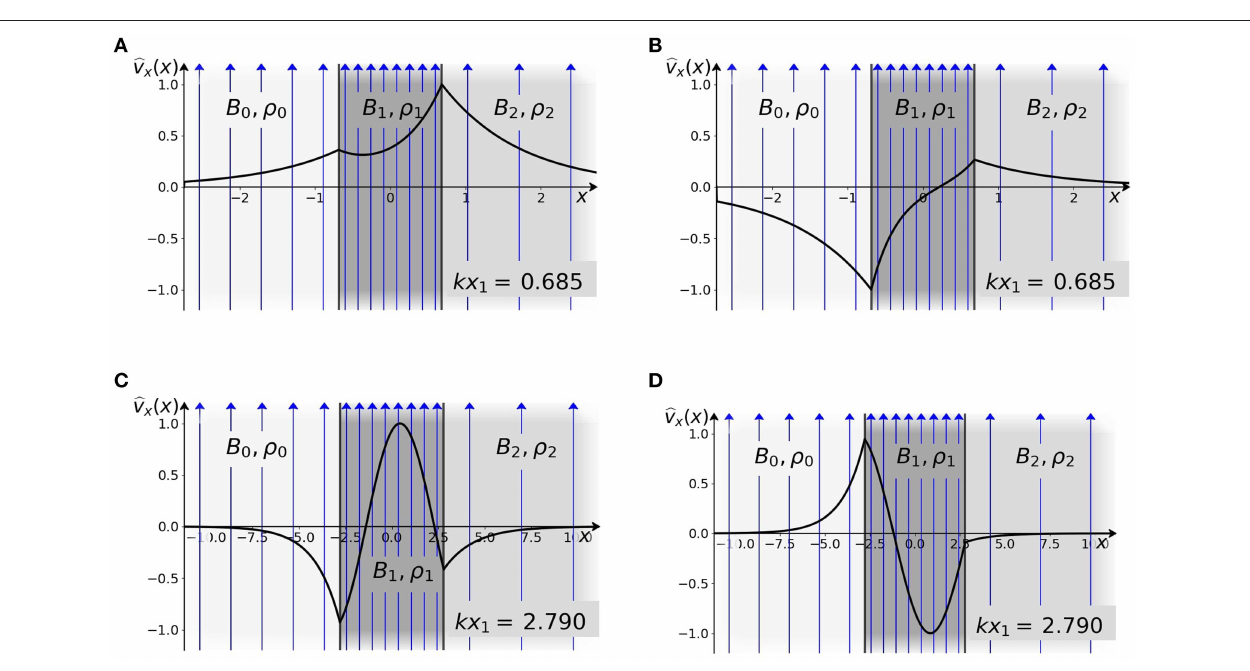
v x ) in a strongly magnetized slab and its rarefied asymmetric environment, plotted with solid FIGURE 4 | Distribution of the transverse velocity perturbation amplitude ( ˆ black curves, as a function of the transverse spatial coordinate, x . Lighter gray shading represents lower background densities, while the blue arrows show the equilibrium magnetic fields, and darker gray shading corresponds to higher background densities. In (A) , a slow quasi-kink surface mode, in (B) , a slow quasi-sausage surface mode, in (C) , a fast quasi-kink body mode of order one, and in (D) , a fast quasi-sausage body mode of order one is presented. (A,B) correspond to a thin slab ( kx 1 0.685), while (C,D) represent a wide slab ( kx 1 2.790). These solutions to the dispersion relation (Equation 3.7) were obtained = = numerically, for a slab system characterized by v A